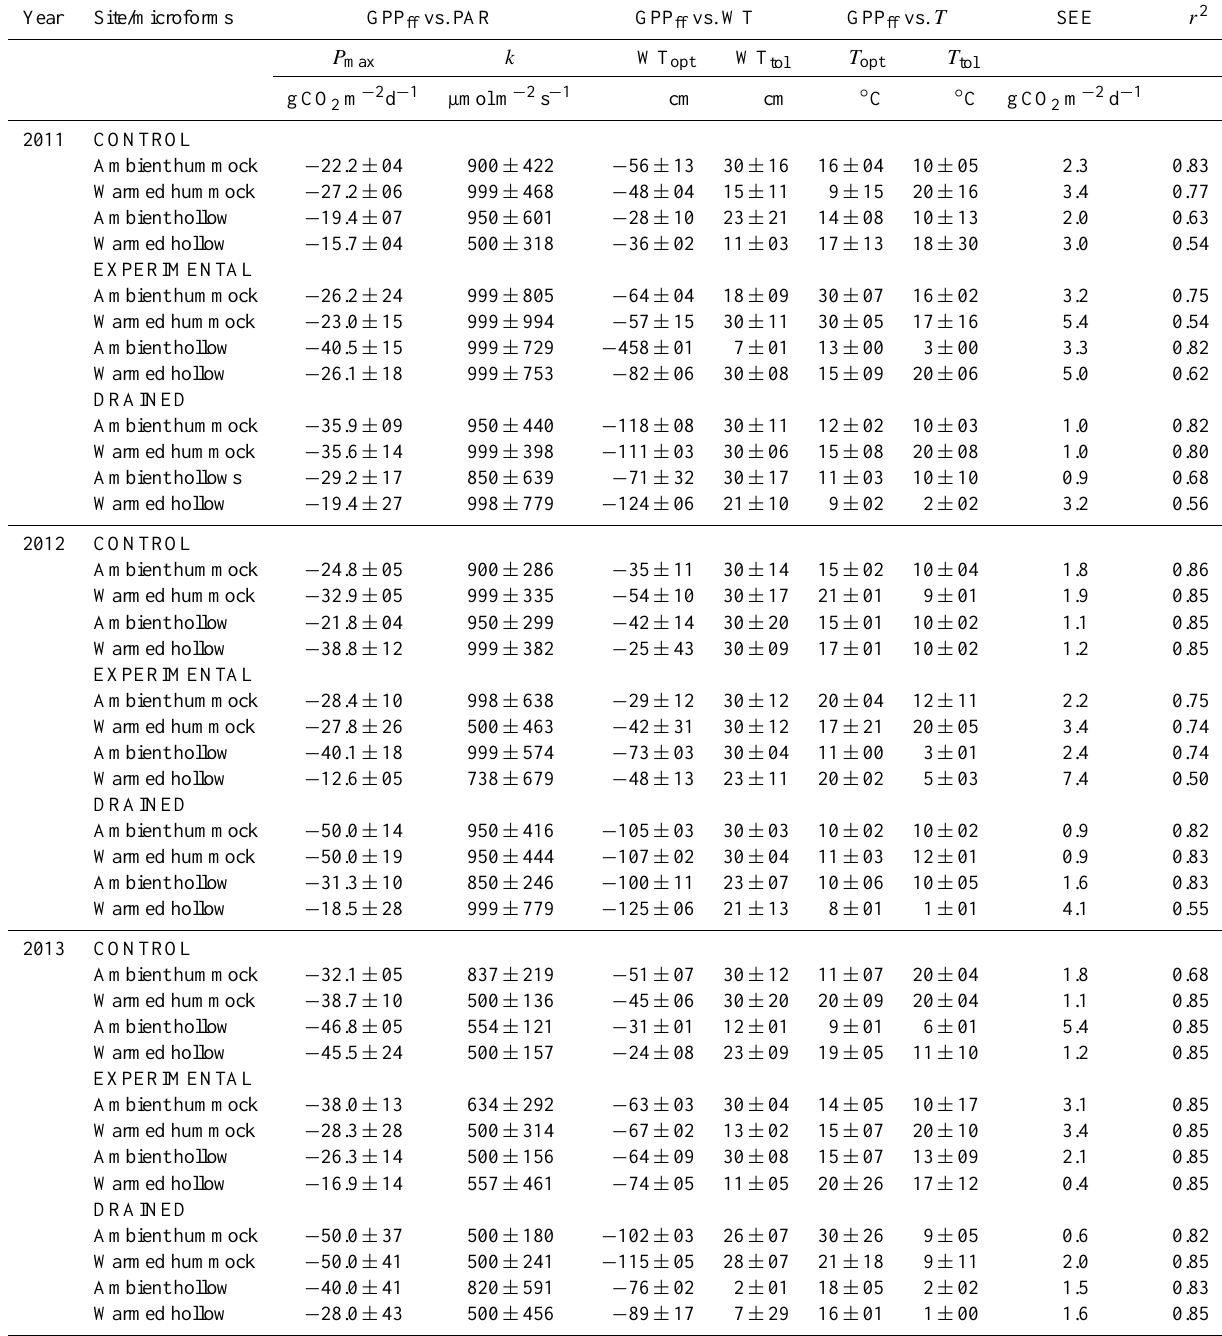
Table A1. Estimated parameter values ( ± SE), standard error of the estimate (SEE) and goodness of fit ( r 2 ) for the gross primary production of forest floor (GPP ff ) model (Eq. 1) ∗